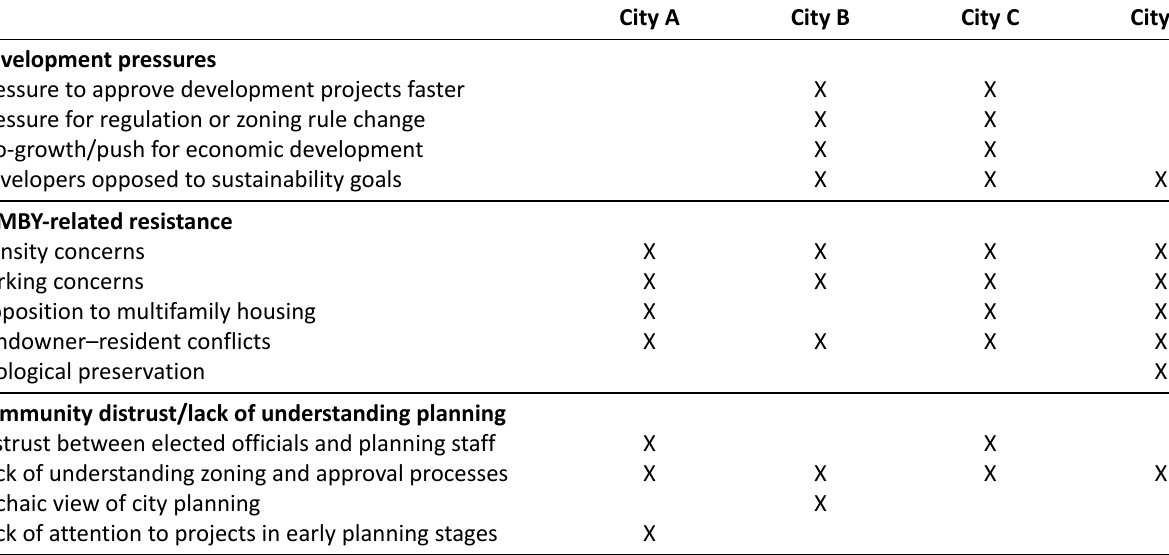
Table 2. Sources of community resistance to sustainable development